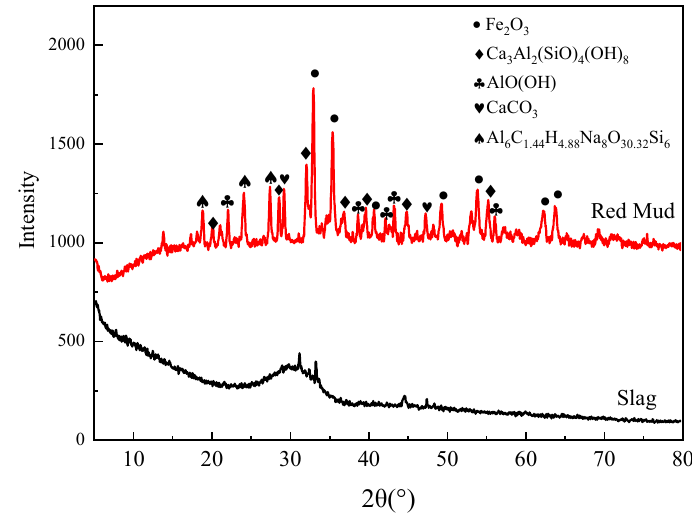
Figure 2. XRD patterns of RM and GGBFS.